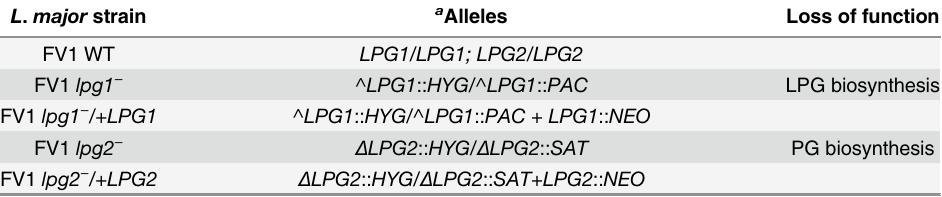
Table 1. Formal names for L . major FV1 LPG and PG null mutants and add back lines. L . major